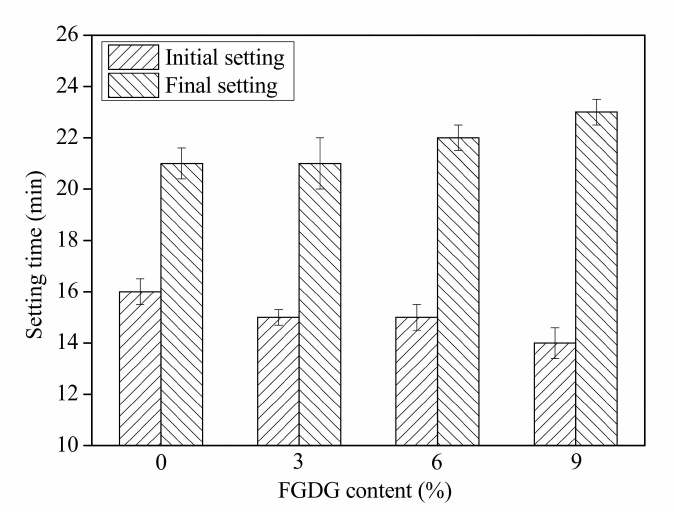
Figure 3. Setting time of CSAC-GGBFS mixtures blended with different FGDG